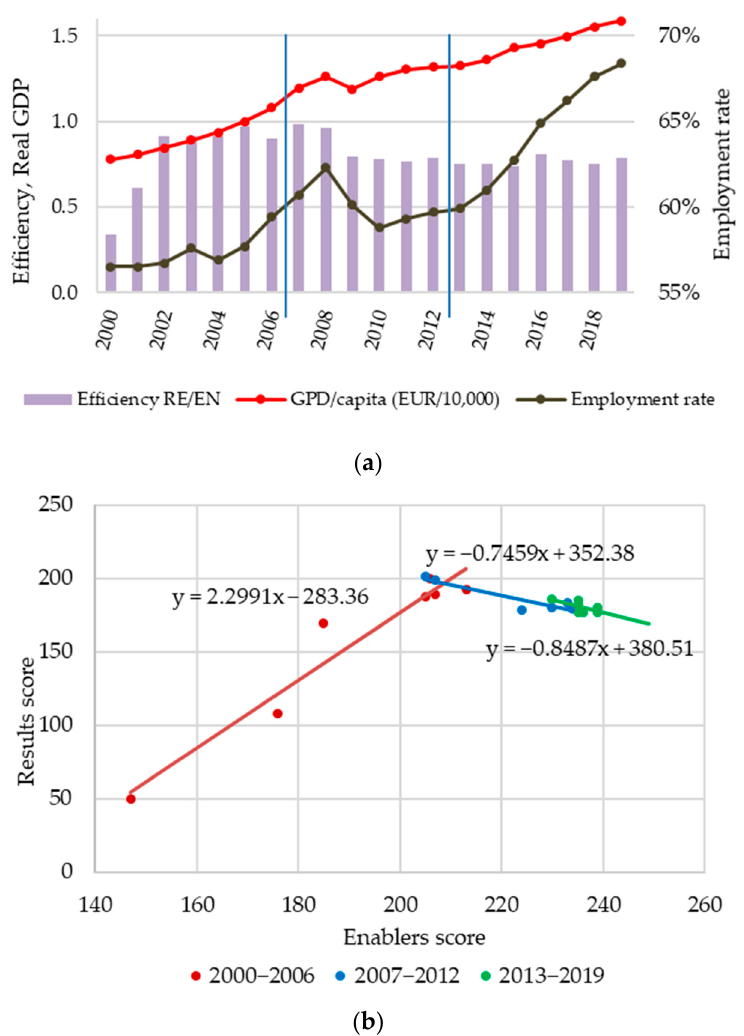
Figure 4. Relationship between results and enablers: ( a ) efficiency, real GDP per capita and employ- ment; ( b ) scatterplot of results against enablers.